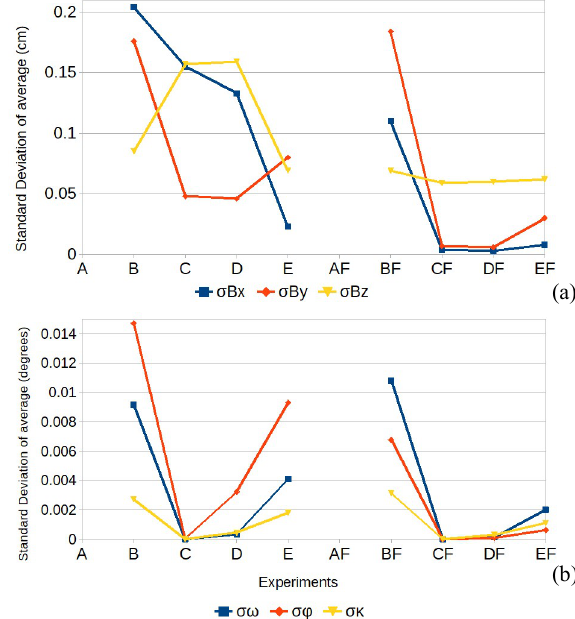
Figure 8. Standard deviation of average values for: (a) base elements and (b) rotation misalignment.